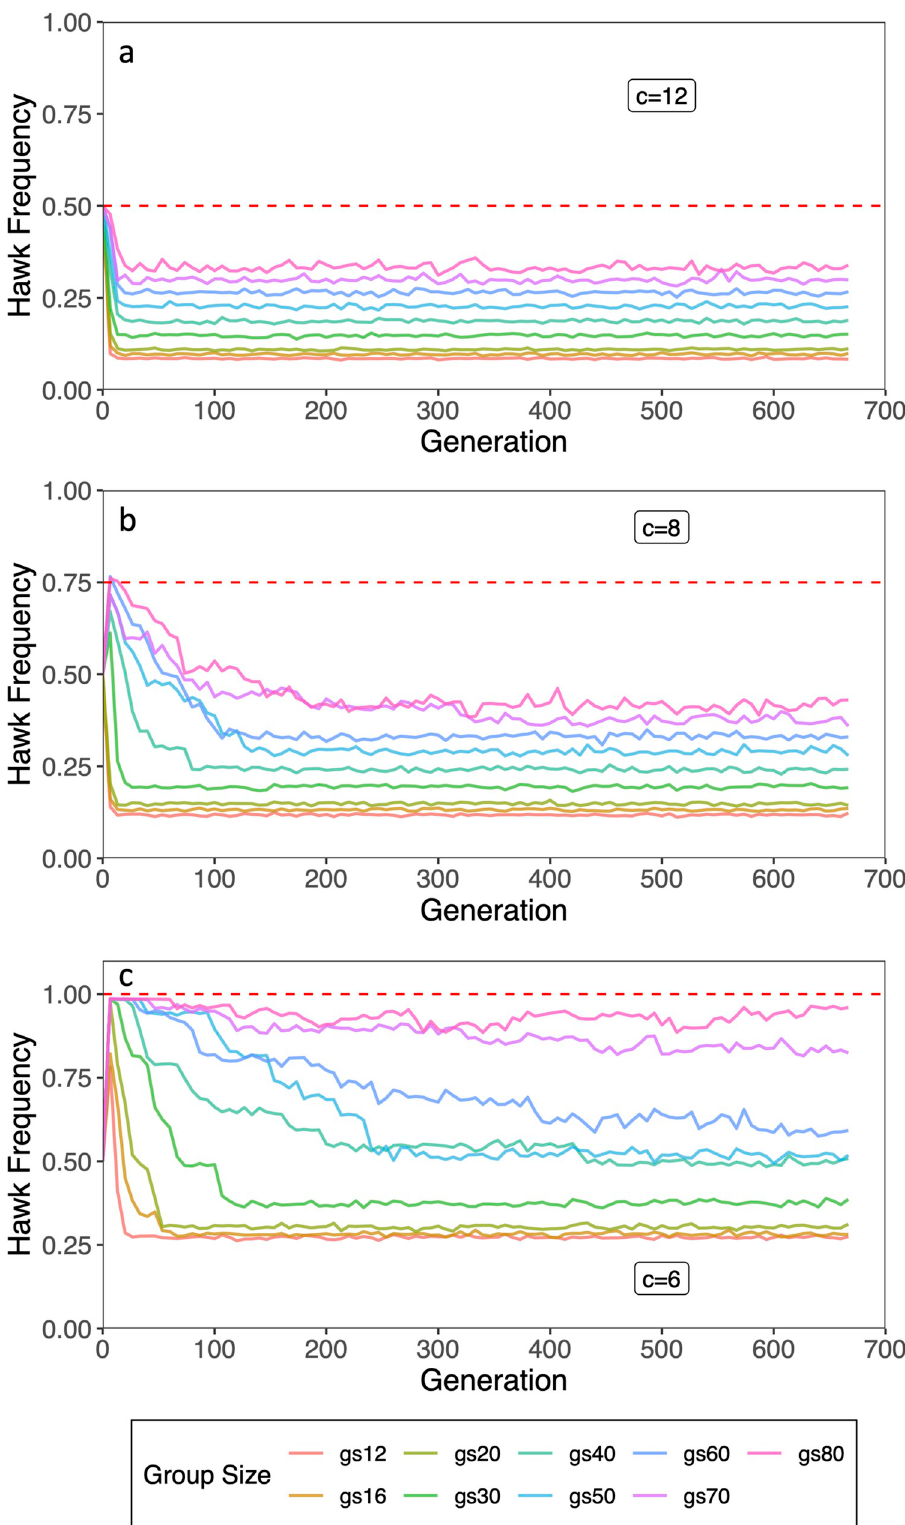
Fig 3. Evolved hawk frequencies varied by maximum group size and benefit-cost ratio. Hawk frequencies were lower than theoretical values in simulations with group structure. Dashed lines indicate the theoretically predicted hawk frequencies, b / c